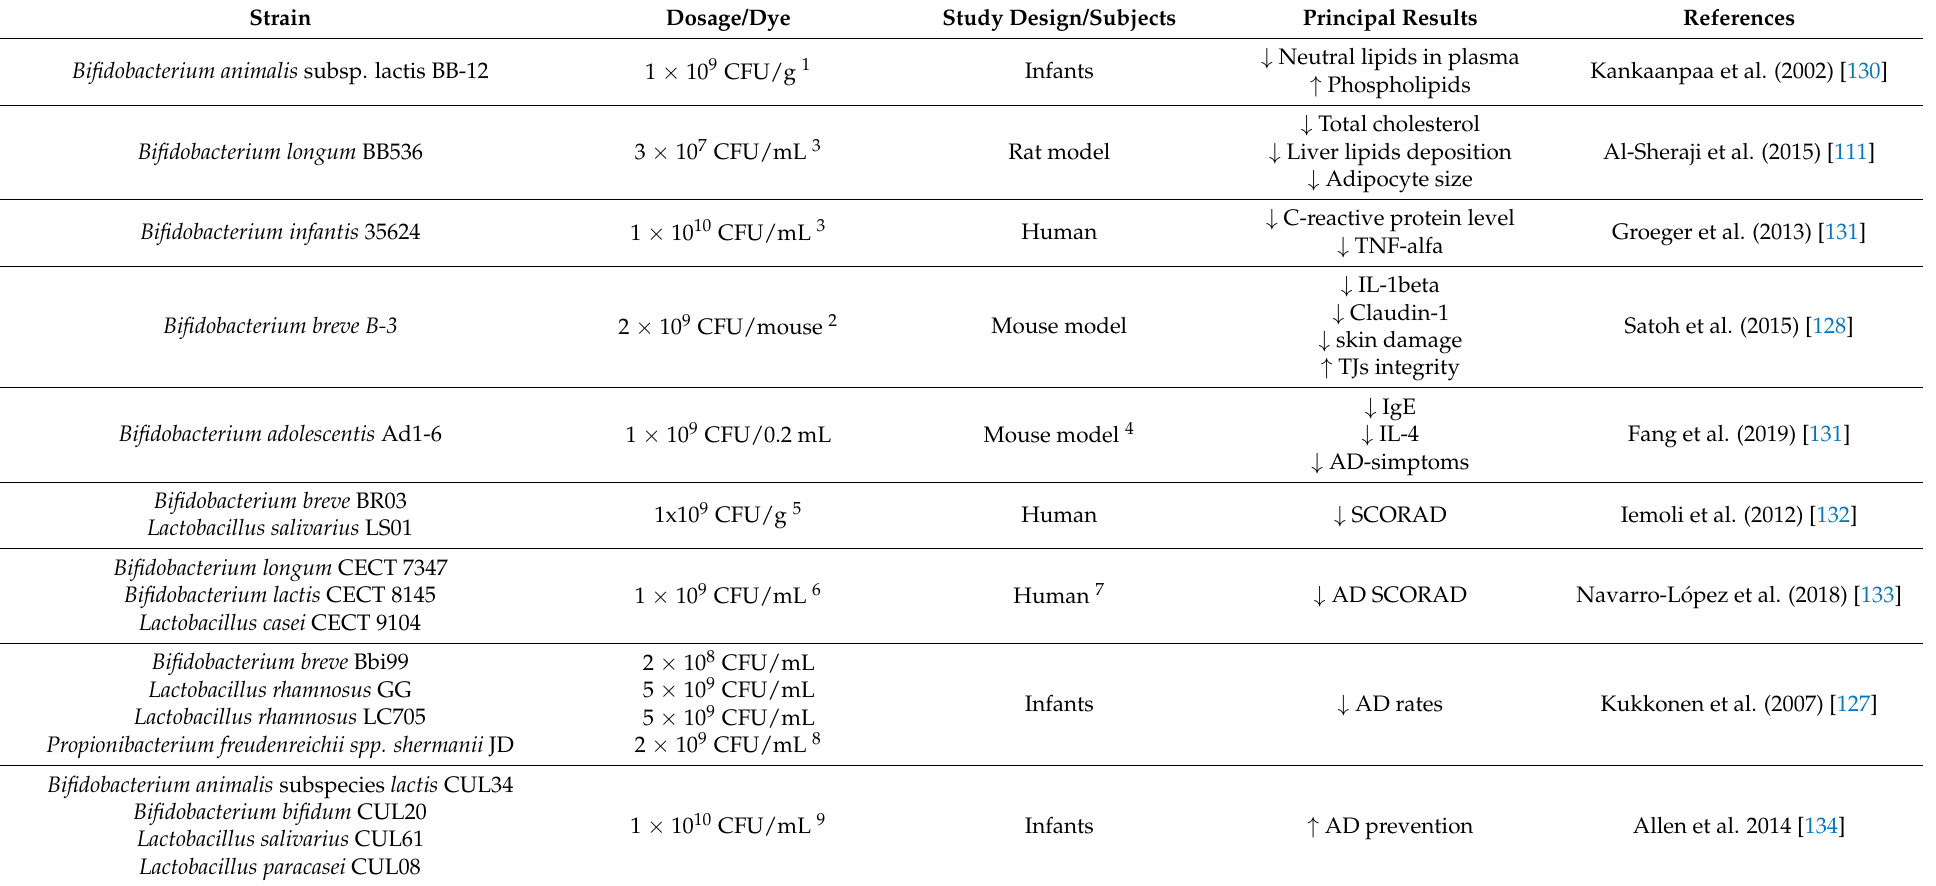
Table 1. Main clinical and experimental studies and principal strain-specific effects of bifidobacteria, used alone and in combination with lactobacilli, on hypercholesterolemia and atopic